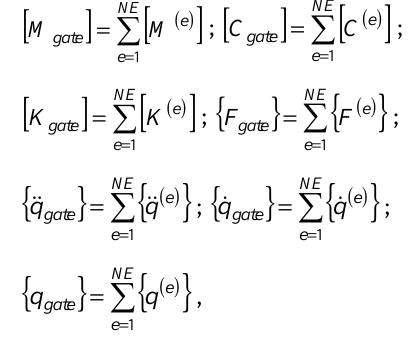
Fig 5. The first-order one-dimensional finite